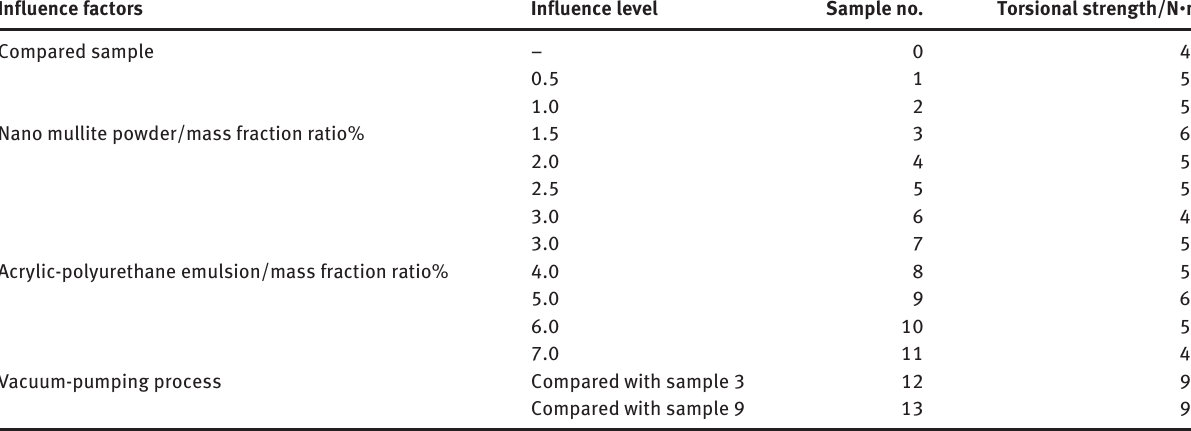
Table 3 Parameters of all